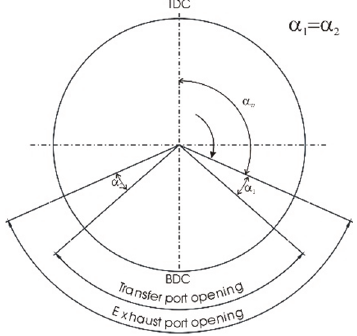
Fig. 3. Symmetric phase timing in two-stroke engine